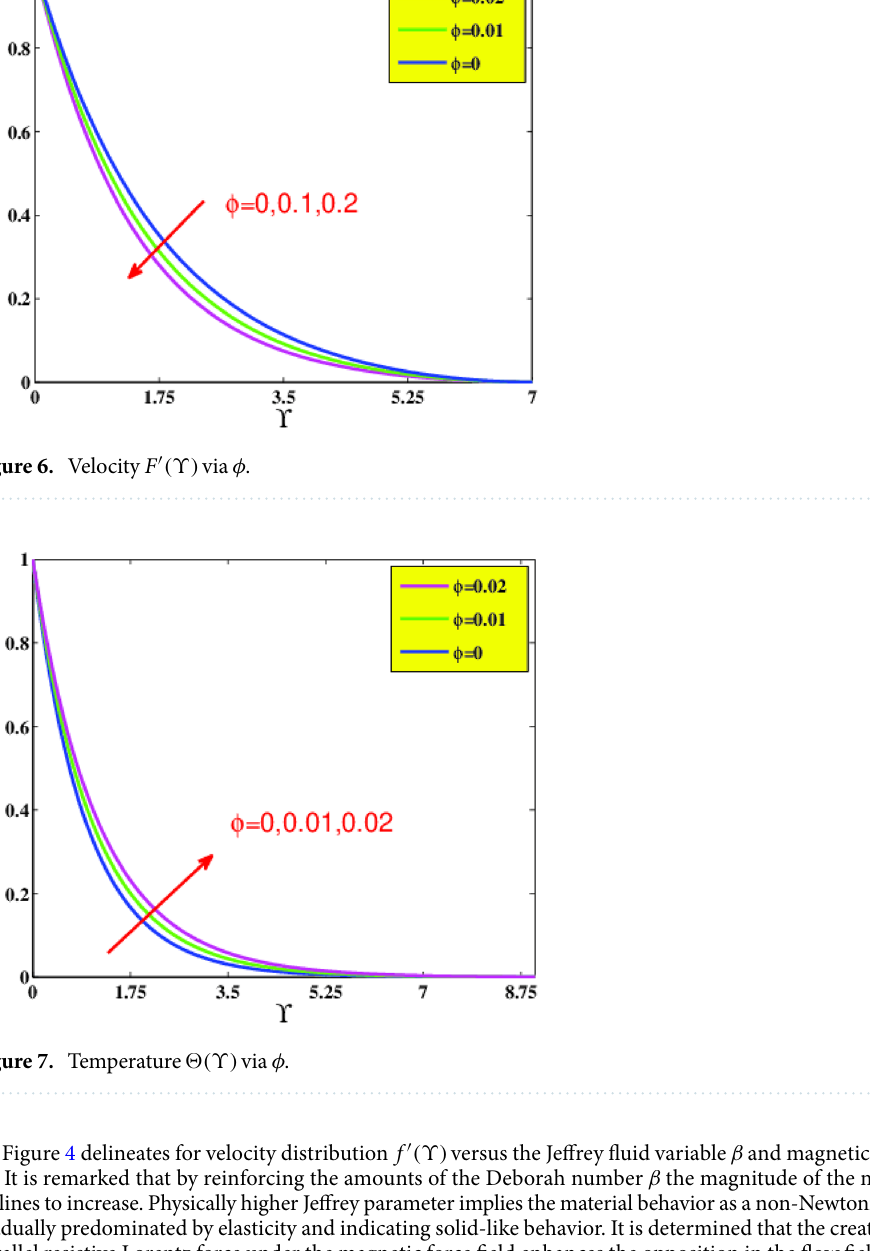
Figure 4 delineates for velocity distribution f ′ ( ϒ ) versus the Jeffrey fluid variable β and magnetic parameter M . It is remarked that by reinforcing the amounts of the Deborah number β the magnitude of the momentum